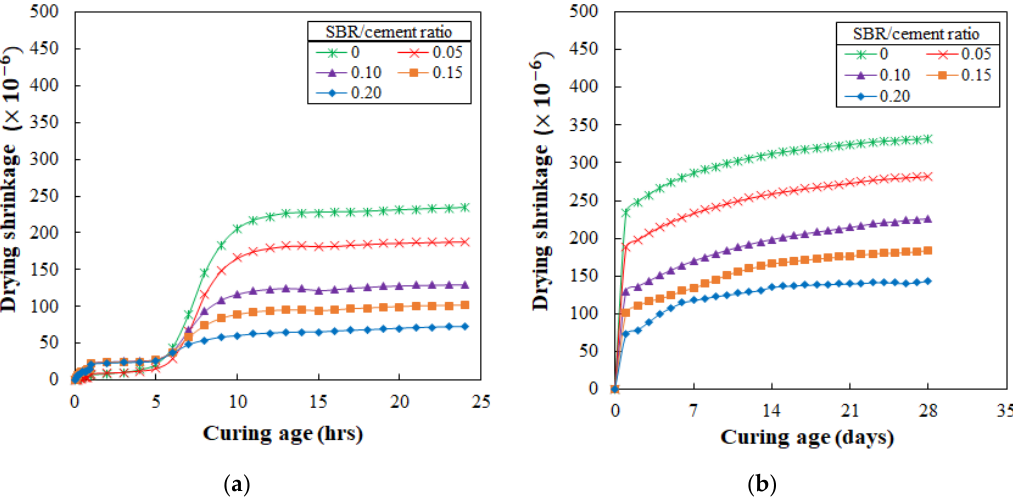
Figure 8. Drying shrinkage strain comparisons for different SBR/cement ratios at ( a ) curing age: 24 hours and at ( b ) curing age: 28 days.